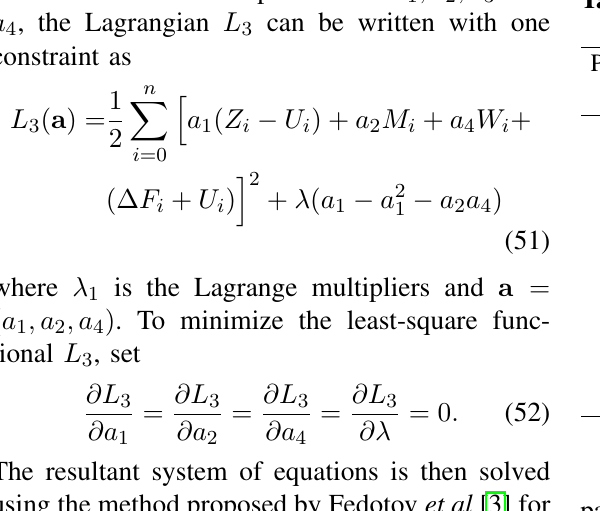
Table 2 : The parameter estimates and